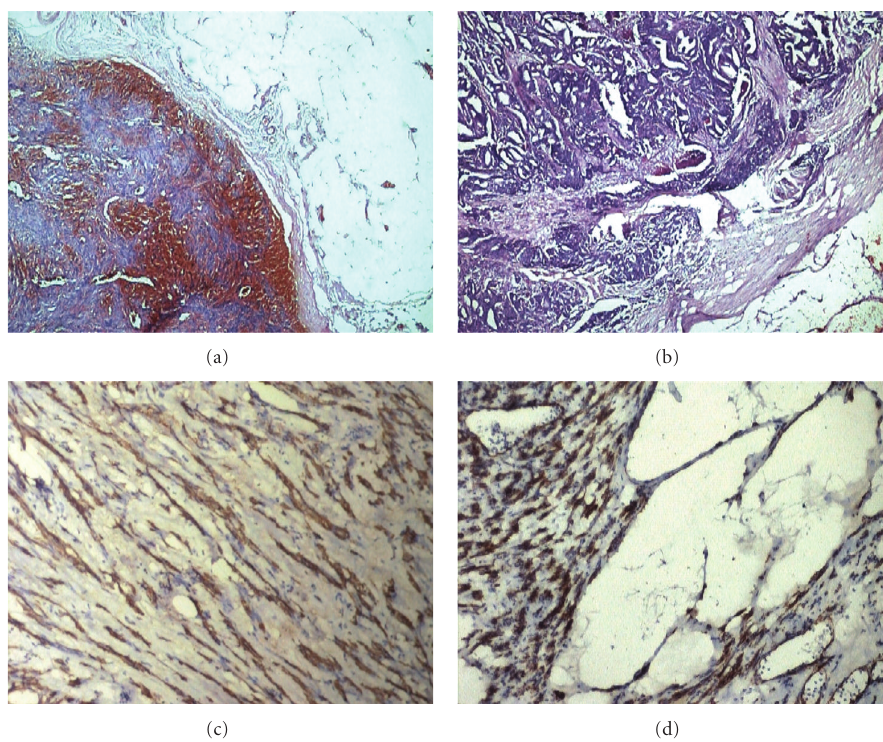
Figure 1: (a) Photomicrograph showing leiomyomata with retrogressive changes (H and E; × 40). (b) One mass revealing metastasis from adenocarcinoma (H and E; × 40). (c) Leiomyoma–positive for Desmin ( × 100). (d) Leiomyoma positive for smooth muscle actin ( ×